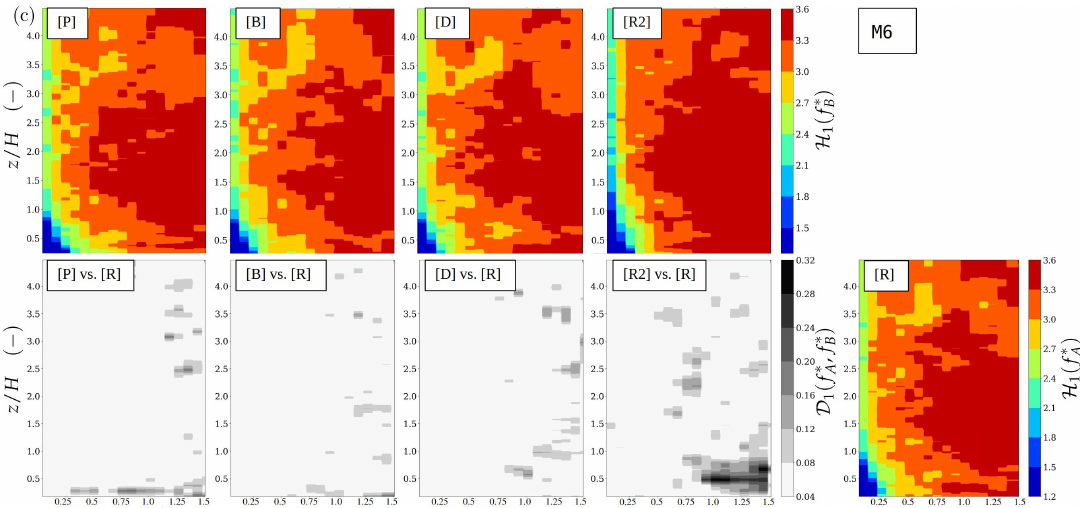
Figure 18. Distributions of Shannon entropy H 1 and divergence D 1 on ( s , z ) -plane evaluated